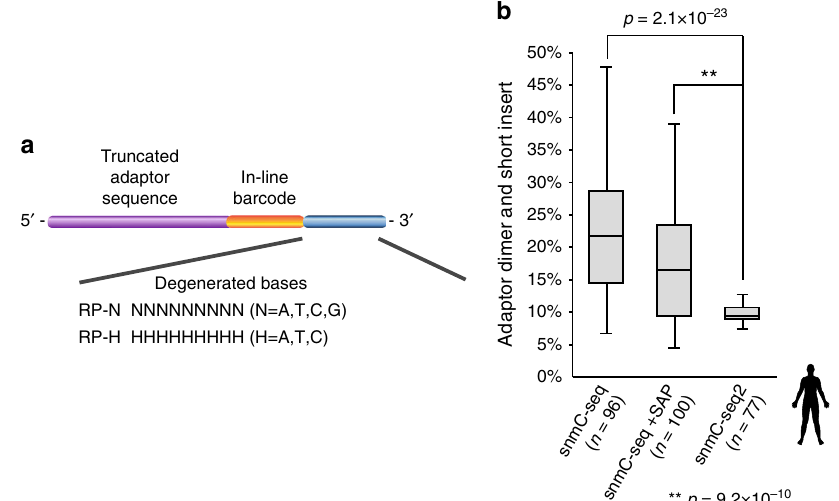
Fig. 2 Reduction of adapter dimer and short insert reads by modulating the degenerate 3 ′ arm of random primers. a RP-H and RP-H oligos are used for snmC-seq and snmC-seq2, respectively. b Adapter dimer and short insert reads were signi fi cantly reduced in snmC-seq2 libraries. The elements of all box- plots are de fi ned as following — center line, median; box limits, fi rst and third quartiles; whiskers, 1.5× interquartile